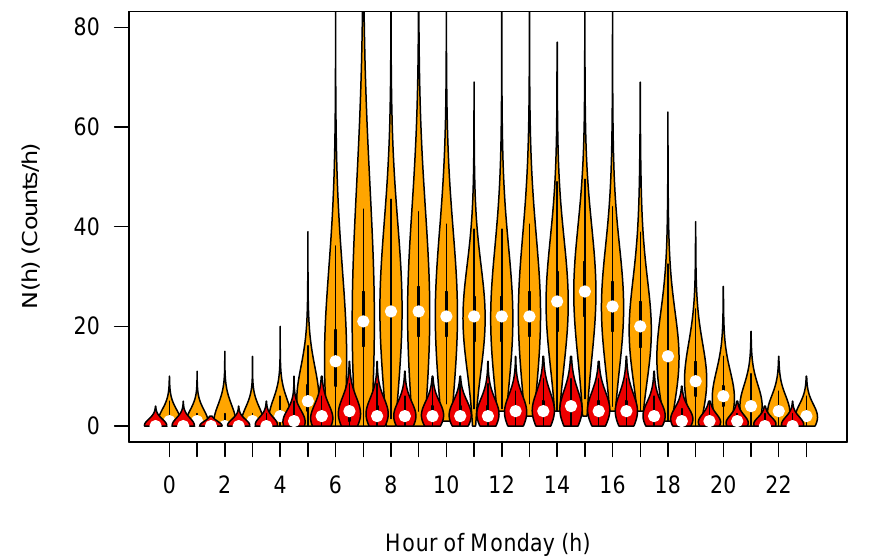
Figure 3. Distribution of the hourly crash counts as a function of the hour of the day on Mondays, displayed as a violin plot. The orange violins are for all crashes, the red ones for the severe crashes (which are shifted left by half an hour). The white circle is the median of the